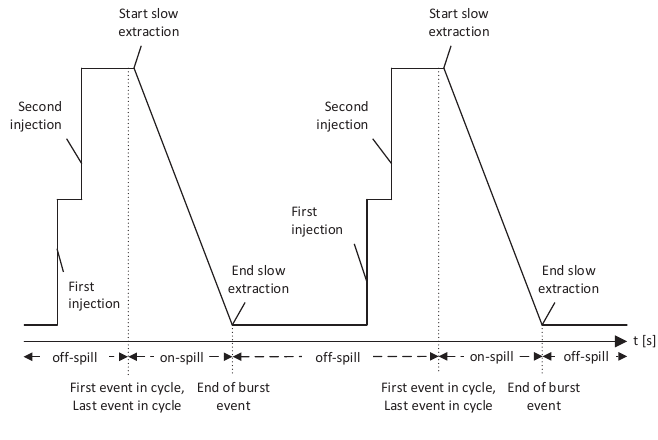
Figure 2. Absolute downtime of the iFDAQ per month and corresponding relative uptime.